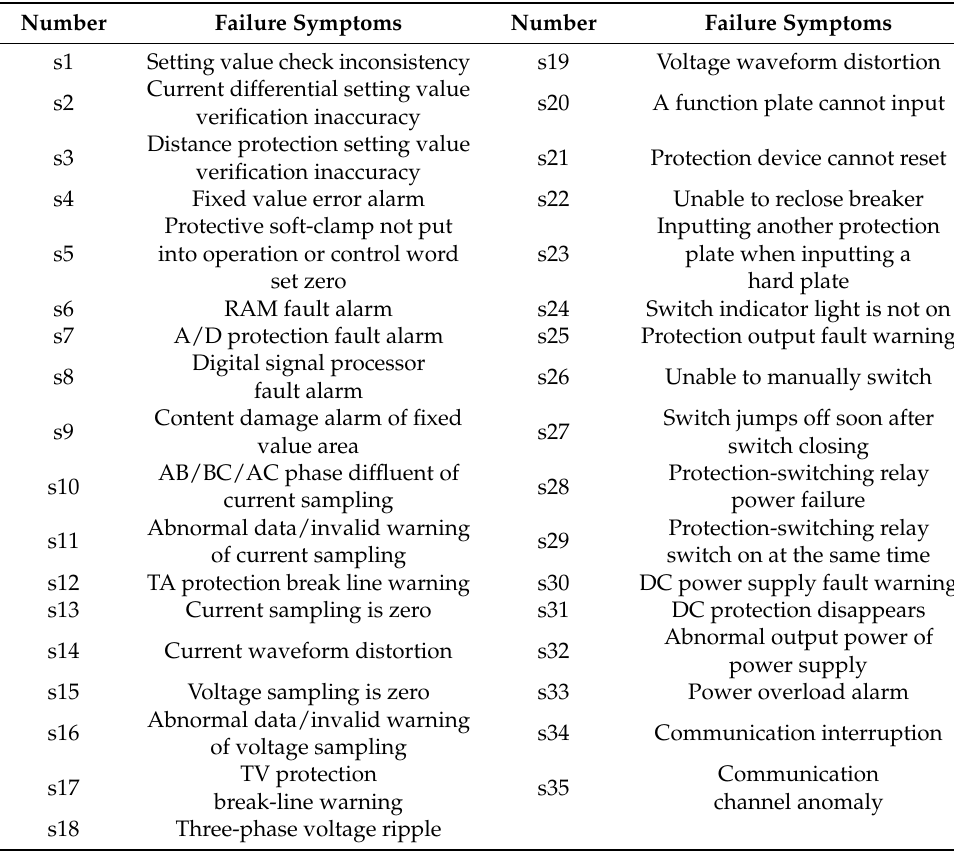
Table 2. Symptoms set of